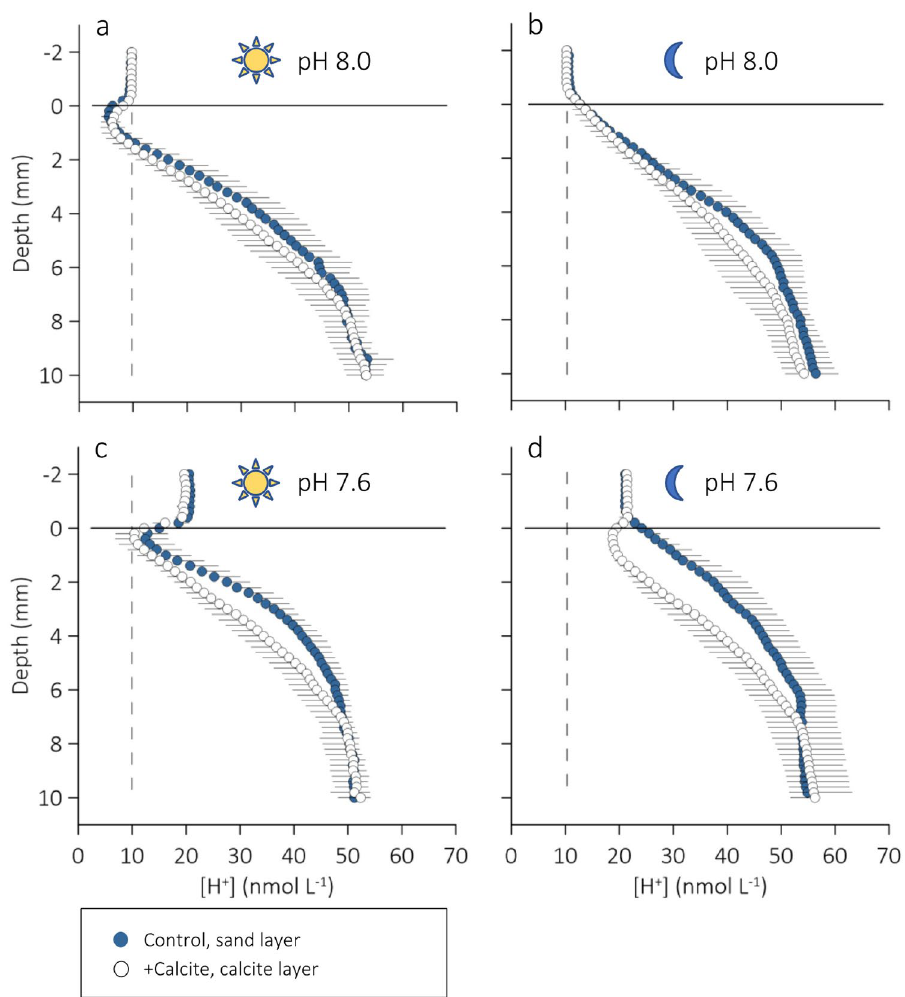
Figure 2. Average (n = 5) vertical microprofiles of porewater [H + ] measured in intact cores of subtidal silt submerged in ( a , b ) ambient seawater and ( c , d ) CO 2 -enriched seawater under conditions of ( a , c ) light and ( b , d ) darkness. A 1 mm surface layer of either sterile sand (blue symbols, Control) or calcite (open symbols, +Calcite) was added to the sediment cores at the start of the experiment. The dashed and solid lines indicate the [H + ] in ambient seawater and the position of the sediment surface, respectively. Black horizontal lines extending to the right or left of the symbols indicate 1 SD. For equilibrium activity ratios of CO 2 to HCO 3 − , see Figure